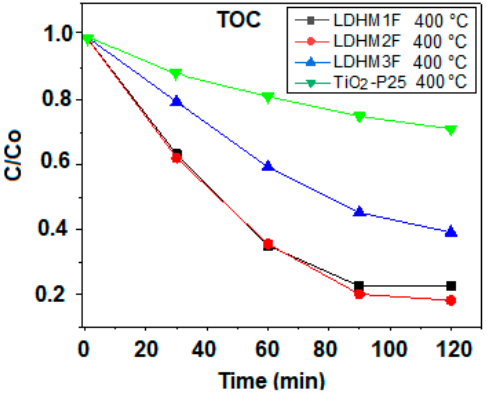
Figure 11. TOC removal during photodegradation of a 2,4,6-trichlorophenol solution.